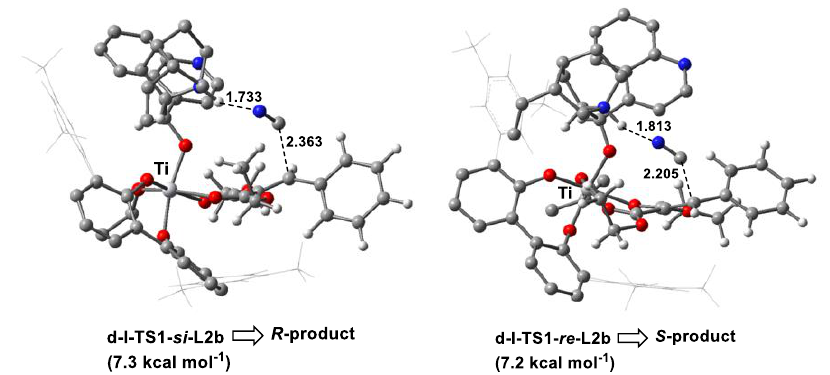
Figure 7. Optimized geometries of TSs in the C-C bond formation step (d-I-TS1- si -L2b and d-I-TS1- re - L2b) in the cyanation reaction of olefins catalyzed by Ti(IV)-complex with L2b along two competing pathways for R - and S -configuration products, respectively, associated with the relative Gibbs free energies. The intermolecular distance is in Angstroms ( Å ). The color definitions of atoms are red = oxygen, blue = nitrogen, gray = carbon and white =